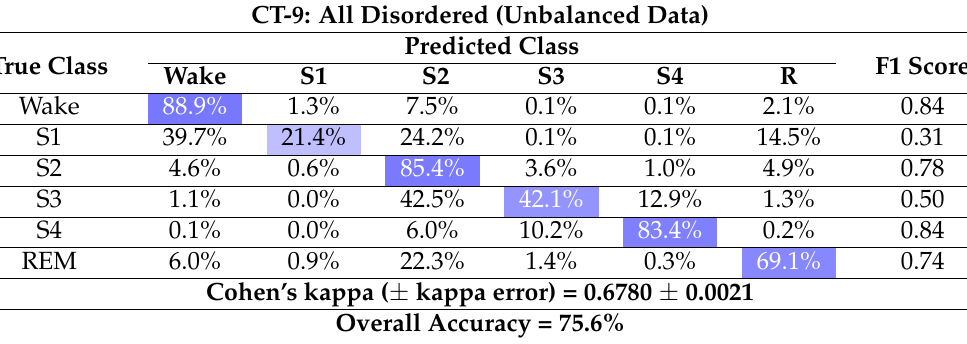
Table 25. Confusion matrix corresponding to sleep stage classification of all disorders combined with unbalanced data using the EBT classifier with 10-fold CV.